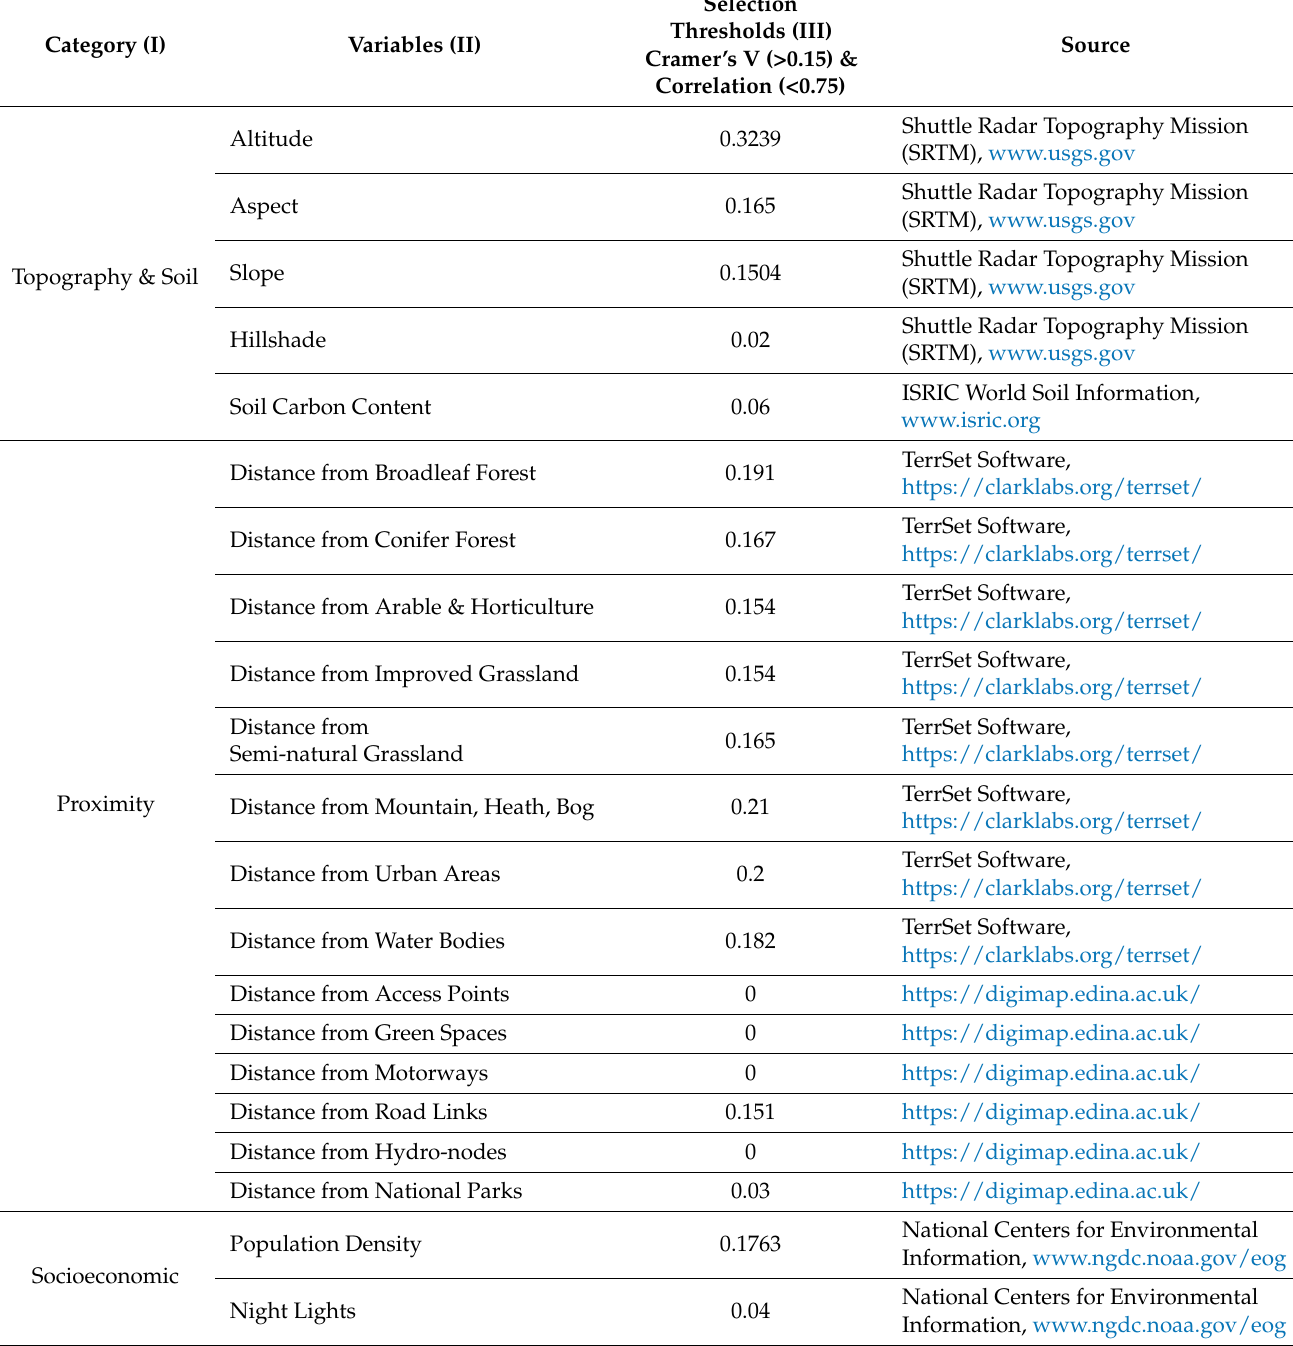
Table 1. Explanatory variables considered in this study. Column (I) shows the categorization of variables, column (II) lists all considered explanatory variables in each class, and finally column (III) shows the Cramer’s V value of each variable. Variables with Cramer’s V < 0.15 were deselected in the first step, the remaining variables were then tested for correlation and the least correlated variables retained (highlighted in